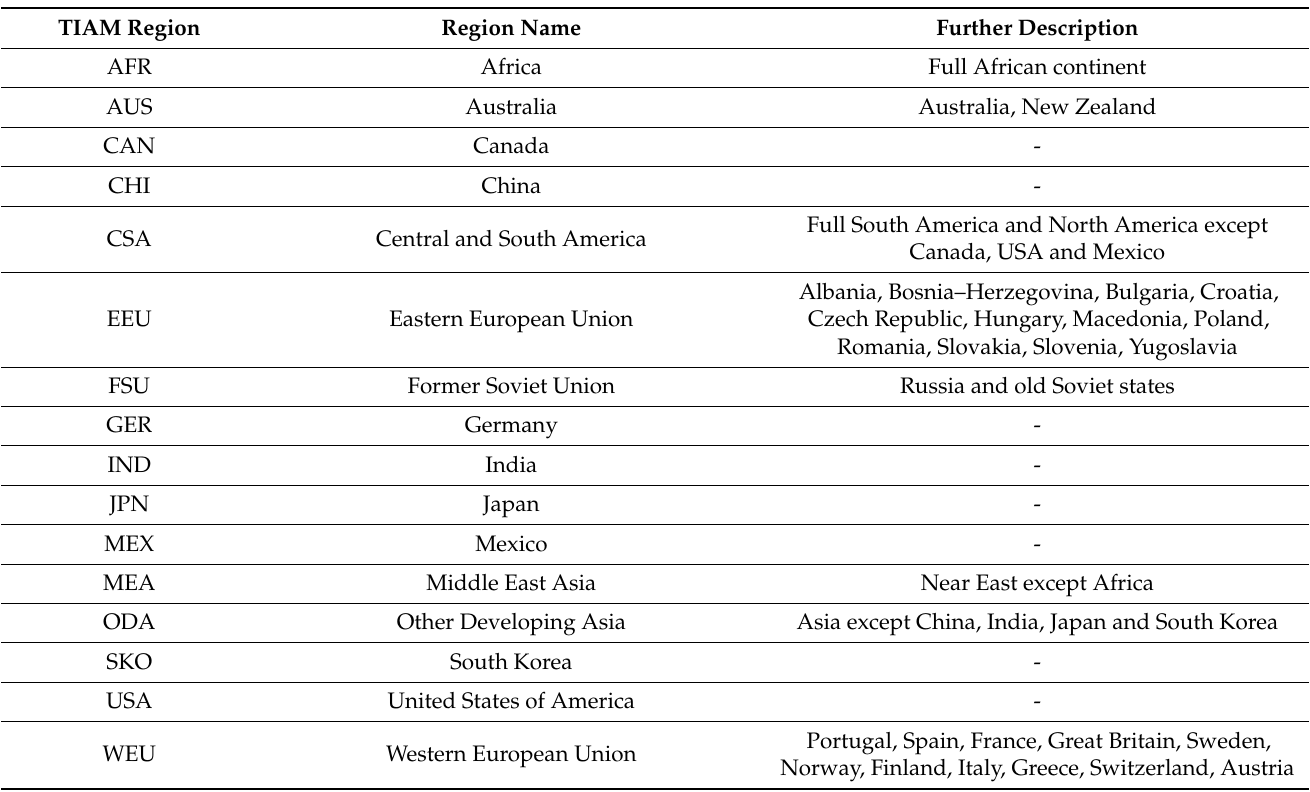
Table A3. Description of TIAM regions; compare [59].